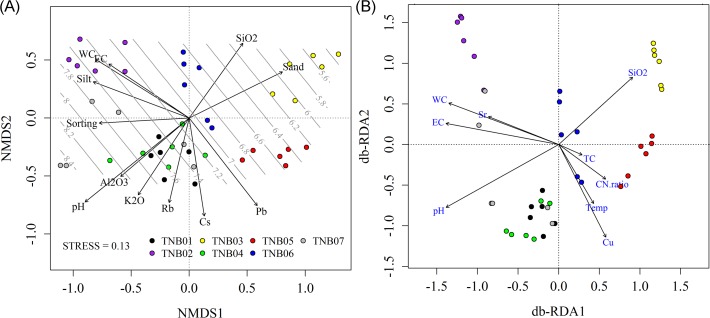
Community composition at the OTU-level.(A) Unconstrained (NMDS) and (B) constrained (db-RDA) ordinations. Highly correlated and significant environmental variables were overlaid onto the NMDS space. Soil pH was linearly correlated with the ordination space using ordisurf.